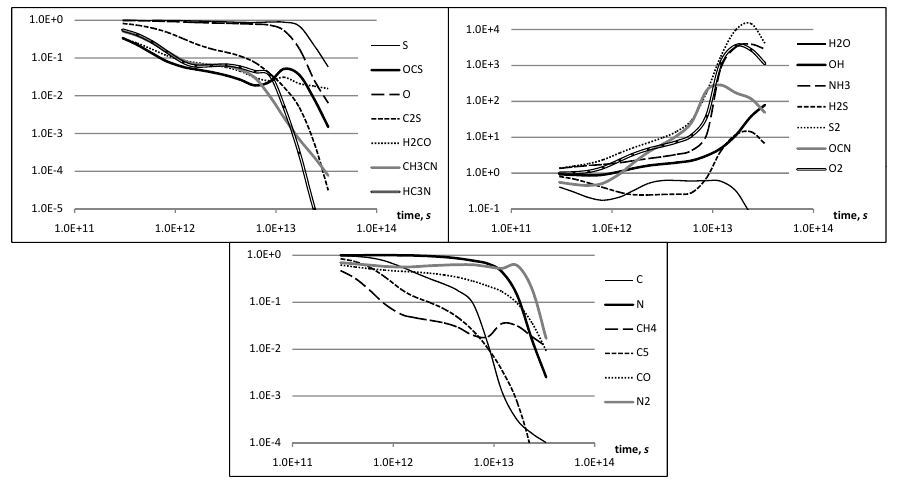
Fig. 5. The comparison of calculated gas-phase abundances for selected species be- tween Model 2 (with freeze processes) and Model 1. The ratio of Model 2 to Model 1 gas abundances is shown. Pay attention to the M2/M1 (ordinate) scale for each graph.